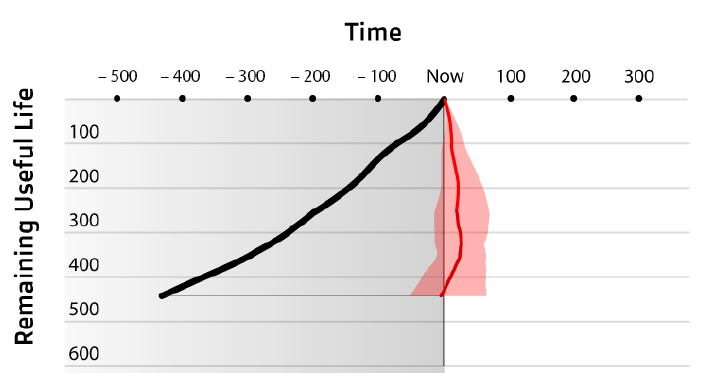
Figure 12. RUL visualisation at the end of life, with the resulting triangular shape showing that all predictions were very close to the real end of life, specially at the start and end of the trajectory. The black line represents the current trajectory. The red line marks all the Expected Ends of Life according to the RUL PDF mean, and the width of the area marks one standard deviation away from the mean.